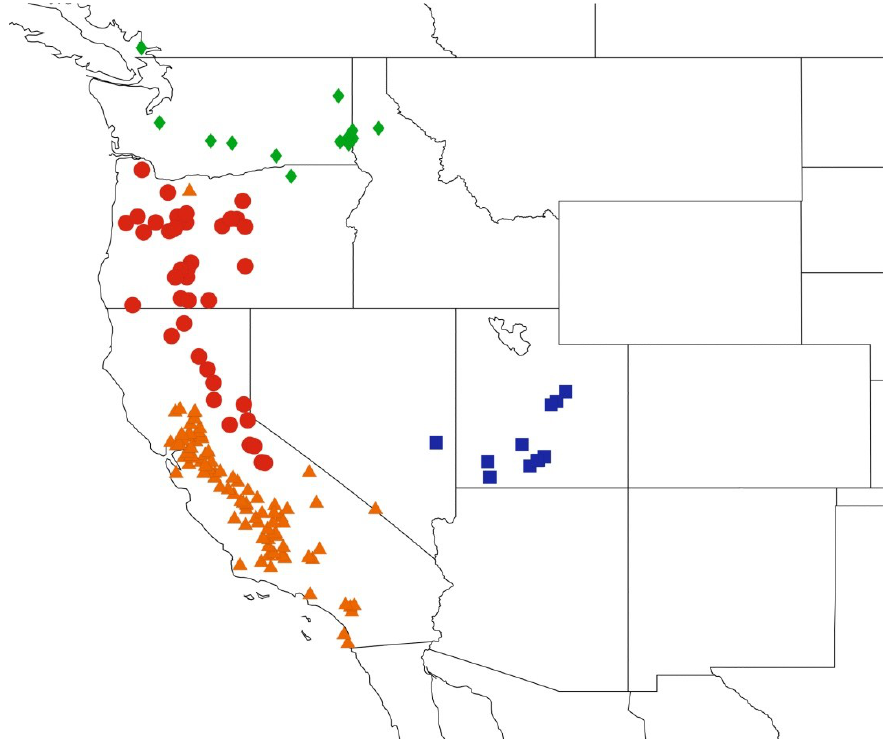
Figure 58. Distribution of Okanagana formosa (blue squares), O. pallidula (orange triangles), O. ferrugomaculata (red circles) and O. lurida (green